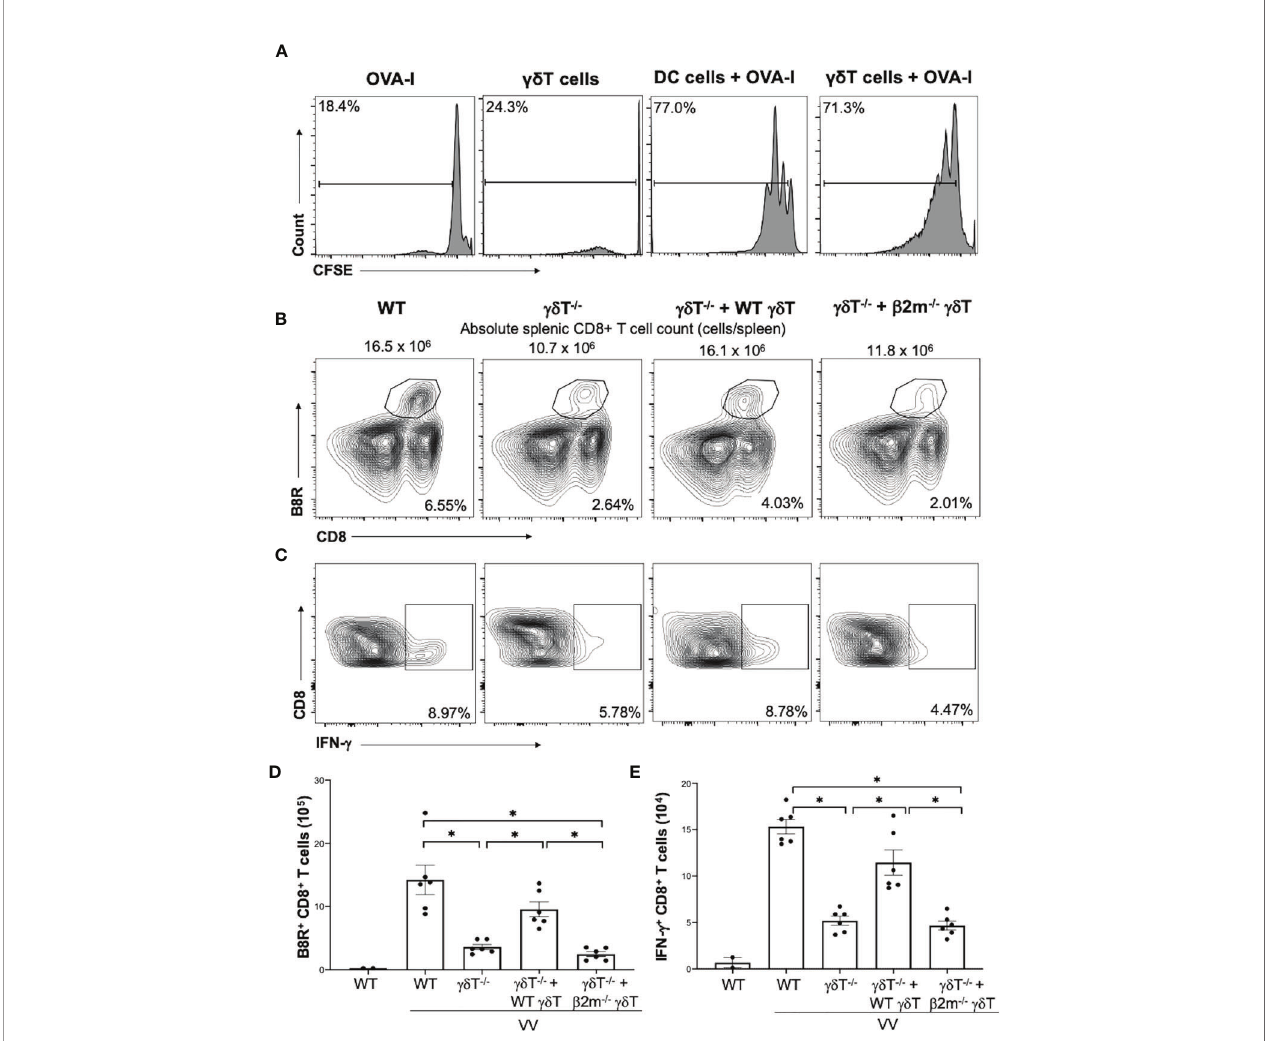
FIGURE 4 | gd T cells directly activate CD8 + T cells via MHC-I. CD8 + T cells were obtained from splenocytes of OT-I + mice via magnetic-activated cell sorting. (A) The CD8 + T cells were labeled with Carboxy fl uorescein diacetate succinimidyl ester (CSFE) and measured for proliferation. The labeled cells were co-cultured in vitro with OVA-I peptide plus LPS-matured dendritic cells or VV-activated gd T cells for 3 days, at a ratio of 1:1. Cells were harvested and stained for CD8 and CD3e. Control CD8 + T cells were incubated with OT-I peptide or gd T cells alone. They were subsequently assessed via fl ow cytometry for CSFE. (B, C) 5 x 10 6 pfu of VV was inoculated intraperitoneally into WT or d TCR -/- mice, with and without adoptive transfer of 1 x10 6 cells of WT or b 2m -/- gd T cells. 7 days post-inoculation, splenocytes were stained for CD8 + CD4 - lymphocytes, and assessed for B8R + and IFN- g + CD8 + T cells. (B) Representative FACS plots fi rst gated on gated on CD8 + CD4 - T cells and then plotted against B8R + and CD8 + T cells for B8R + CD8 + T cells. (C) Representative FACS plots fi rst gated on CD8 + CD4 - T cells and then assessed for IFN- g expression. (D, E) Quanti fi cation of FACS plots. Values are mean ± SEM, representative of 3 independent studies. ANOVA with post-hoc t-test, * P <